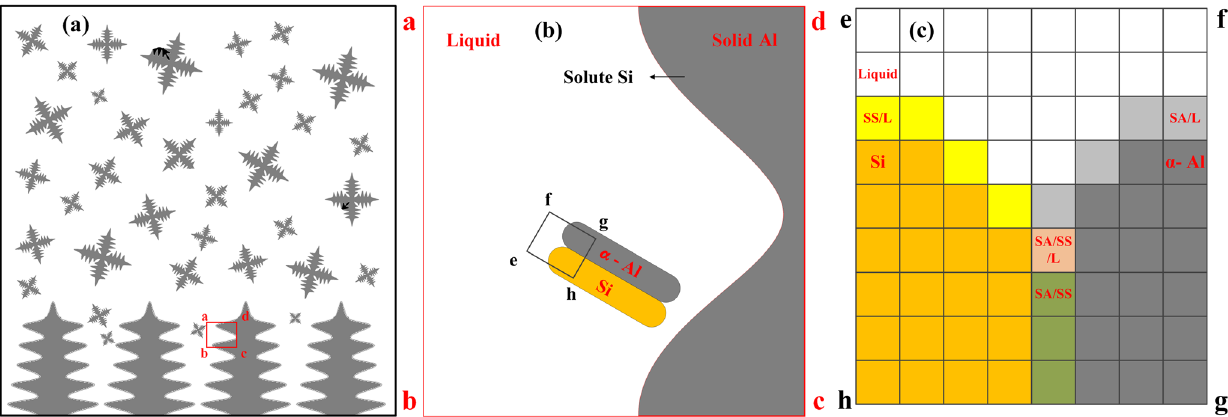
Fig. 9 Schematic diagram of solidi fi cation dendrites and eutectic phases. a Dendrite morphology during solidi fi cation in mesoscale, b eutectic phase near dendrite squared in a , and c the variable of the state in this CA